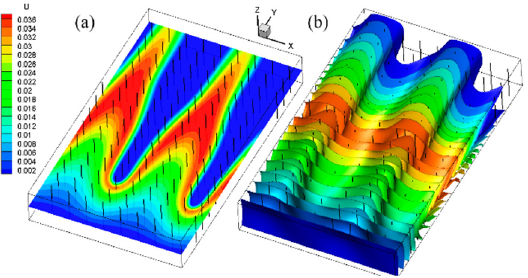
Figure 11. Exploratory wells are put through a synthetic deposit. ( a ) Slice through z -axis; ( b ) iso-surfaces by pressure values in 3D.